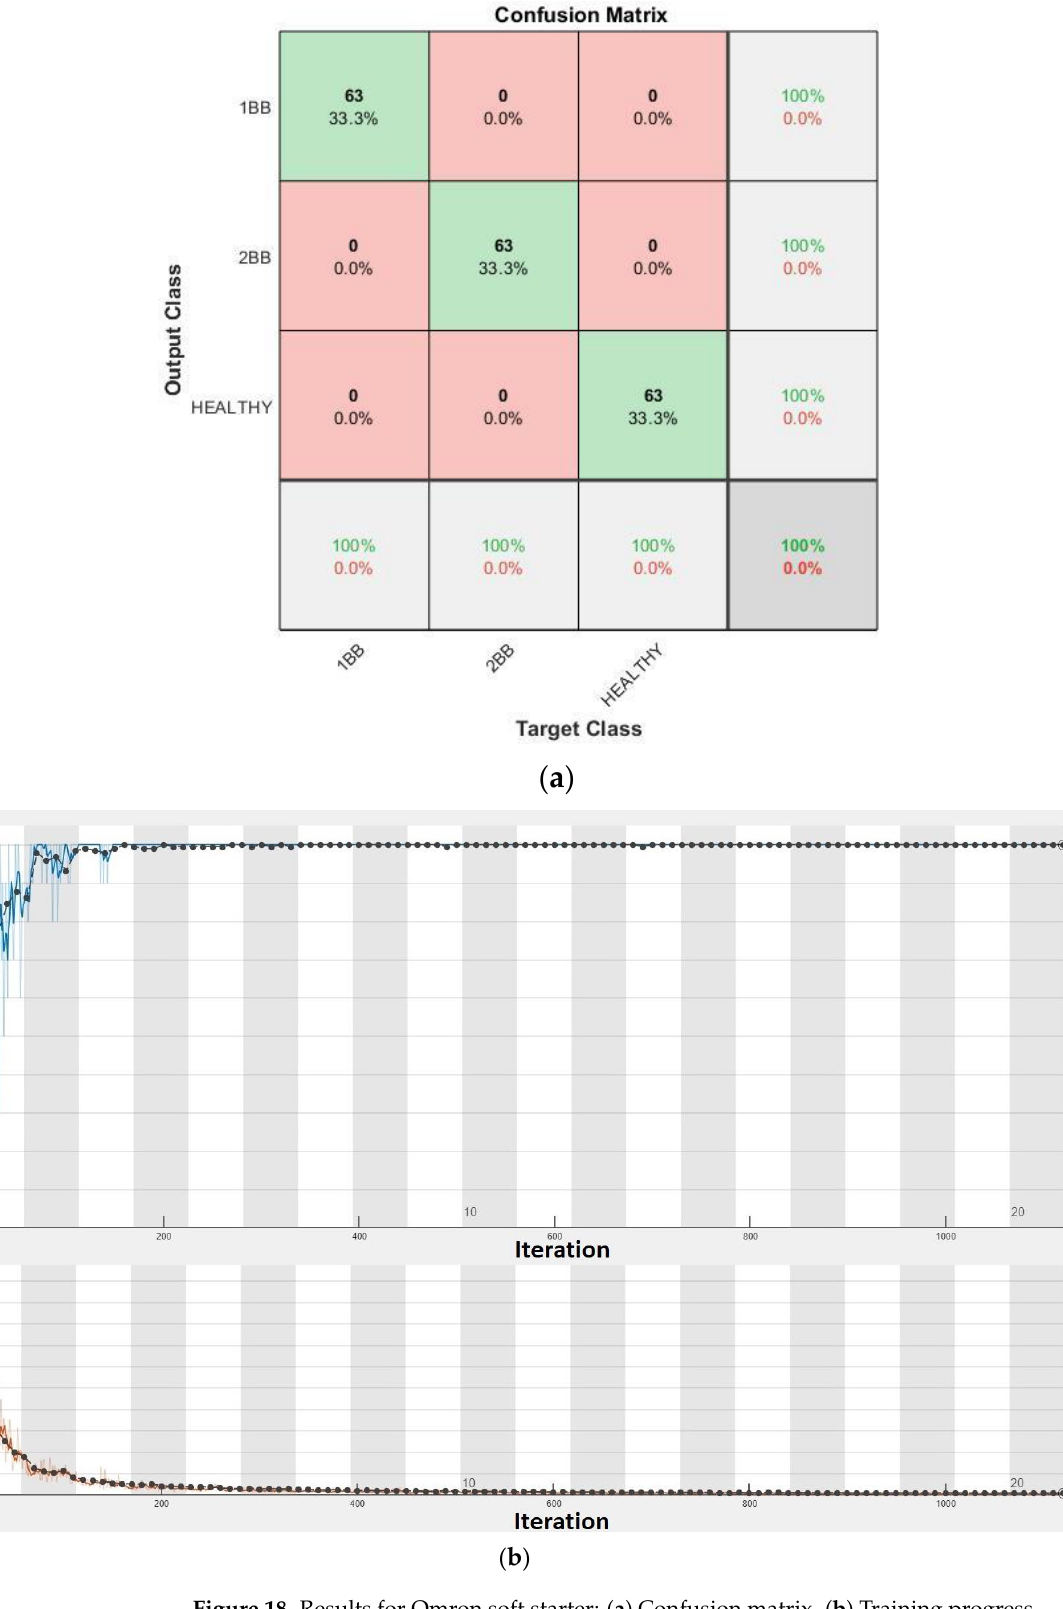
Figure 18. Results for Omron soft starter: ( a ) Confusion matrix. ( b ) Training progress.